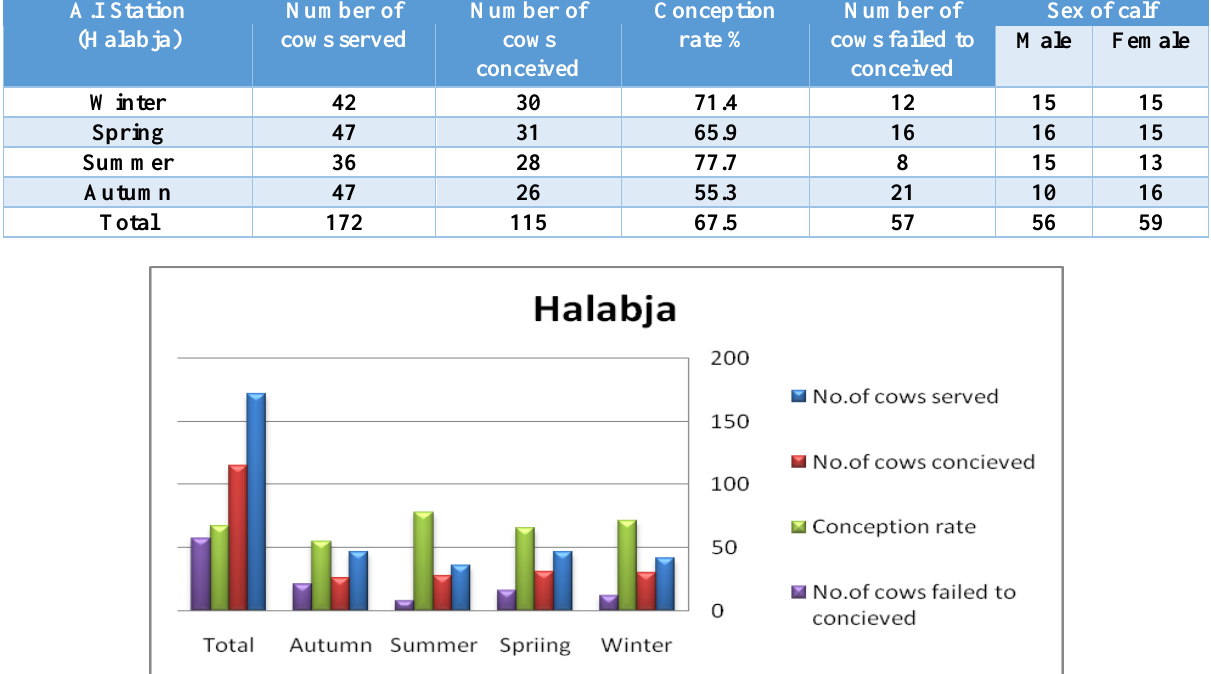
Table, 3: The conception rate of cows and sex of calf in different seasons for Sharazoor